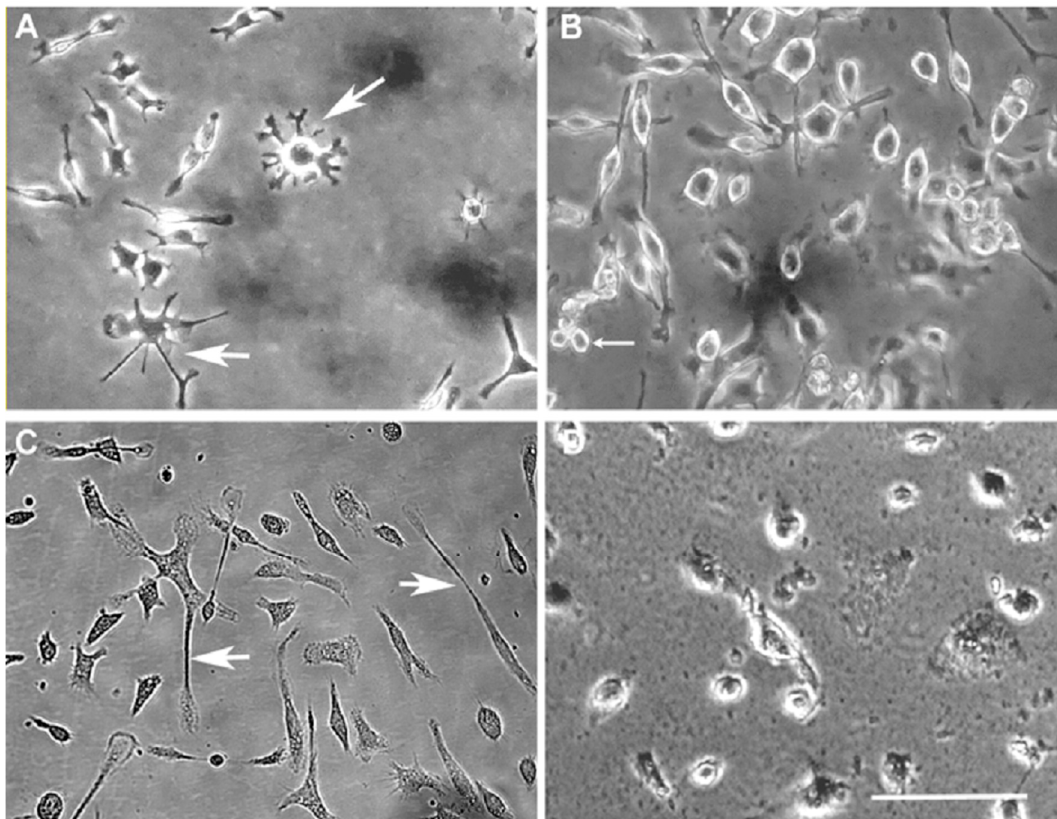
Figure 1. Phenotype of iron-fed microglia. Photomicrographs of microglia were prepared from both C8B4 ( A , B ) and primary mouse microglia ( C , D ) in culture. The microglia were either grown in control